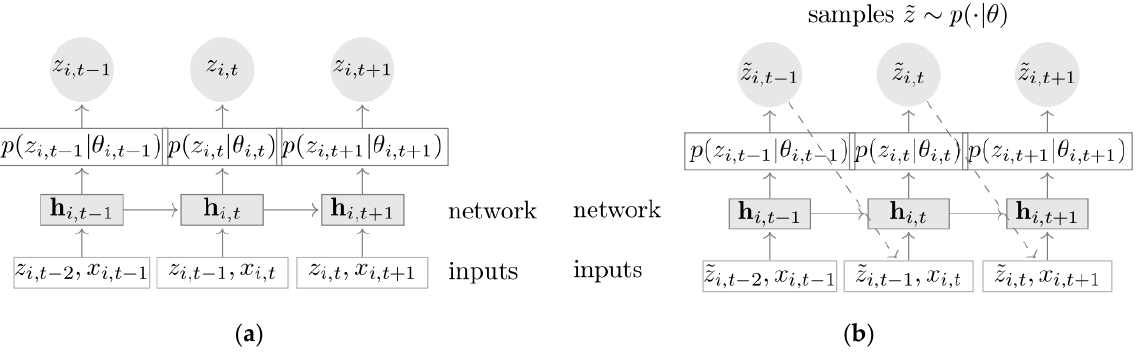
Figure 3. Structure diagram of GRU-DeepAR model [13]: ( a ) training stage of GRU-DeepAR model; and ( b ) prediction stage of GRU-DeepAR model.